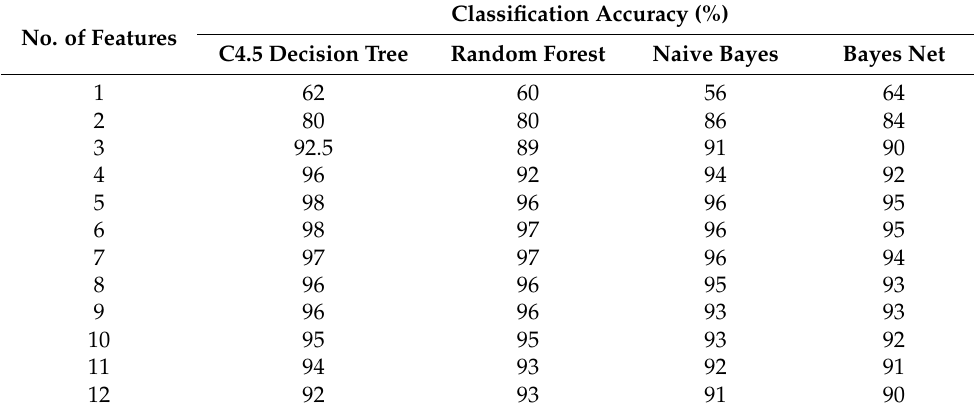
Table 7. Effect of the number of features on classification accuracy—Experimental data. No. of